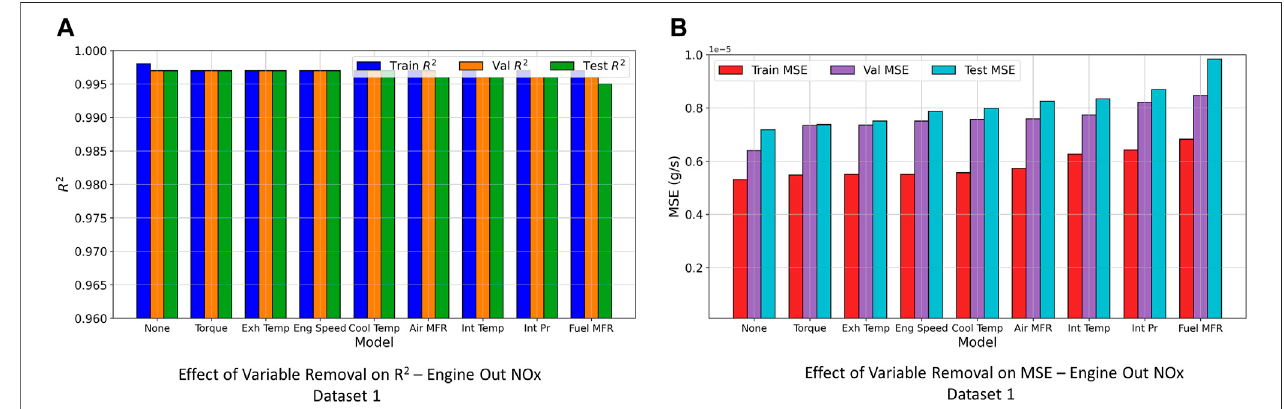
FIGURE 9| Effect of variable removal on model performance (Engine out NO x model Dataset 1). (A) Effect ofVariable Removal on R 2 — Engine Out NOx Dataset 1. (B) Effect of Variable Removal on MSE — Engine Out NOx Dataset